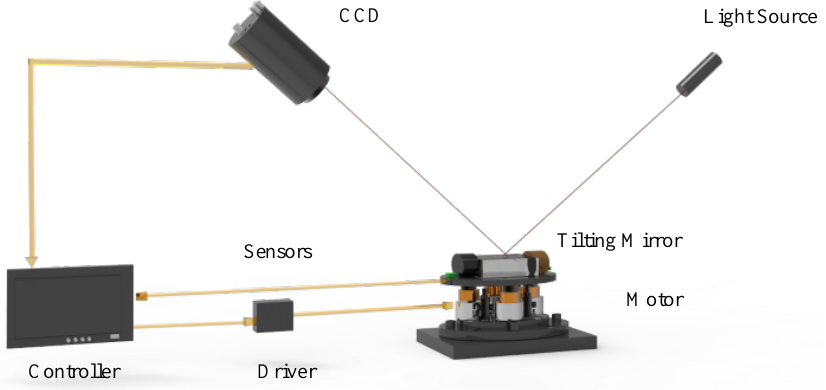
Figure 1. Structural sketch of stable control platform [13].